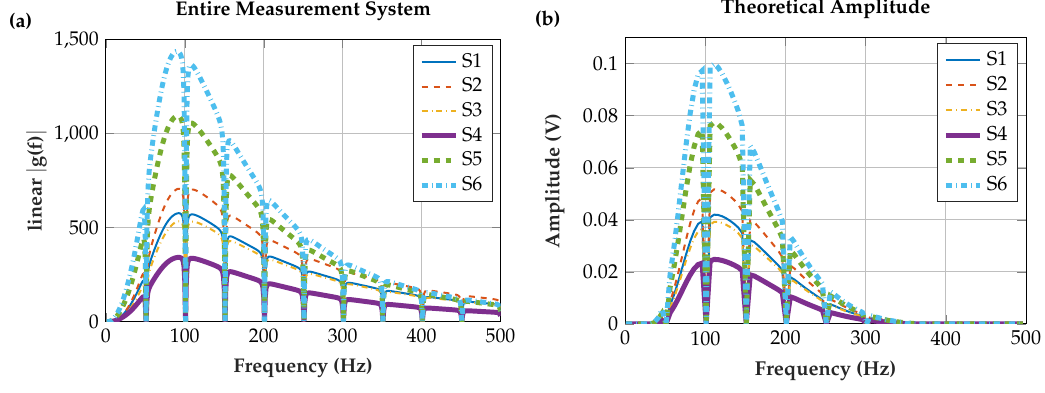
Figure 16. ( a ) Transfer function of the entire measurement system. Cascading of the transfer functions of the input stage, analog bandpass, digital signal processing and frequency independent amplification. ( b ) Calculated EMG amplitude spectrum (resolution ∆ f = 1 Hz). The transfer function of the entire measurement system in ( a ) was applied to the theoretical EMG input amplitude spectrum as defined in Figure 9. The resulting shape is in accordance with the measured EMG amplitude spectrum in Figure 13, as the theoretical and the real measurement system have similar transmission behavior. Note that the theoretical amplitude is based on the smoothed amplitude